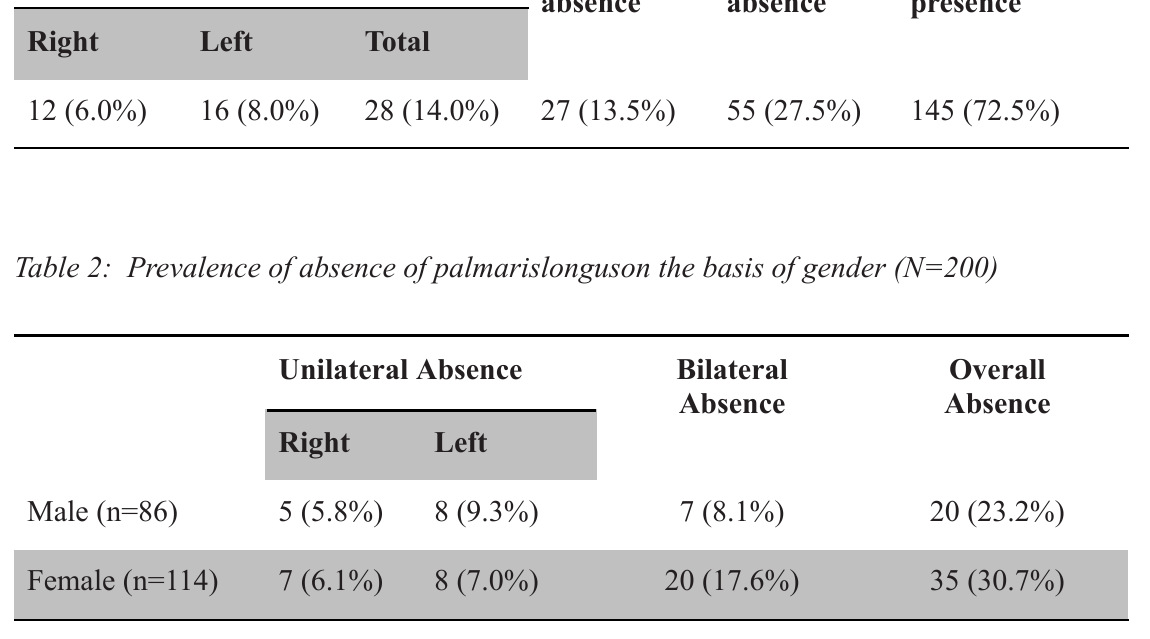
Table 1: Prevalence of Absence of palmaris longus on the basis of laterality (N=200) Unilateral Absence